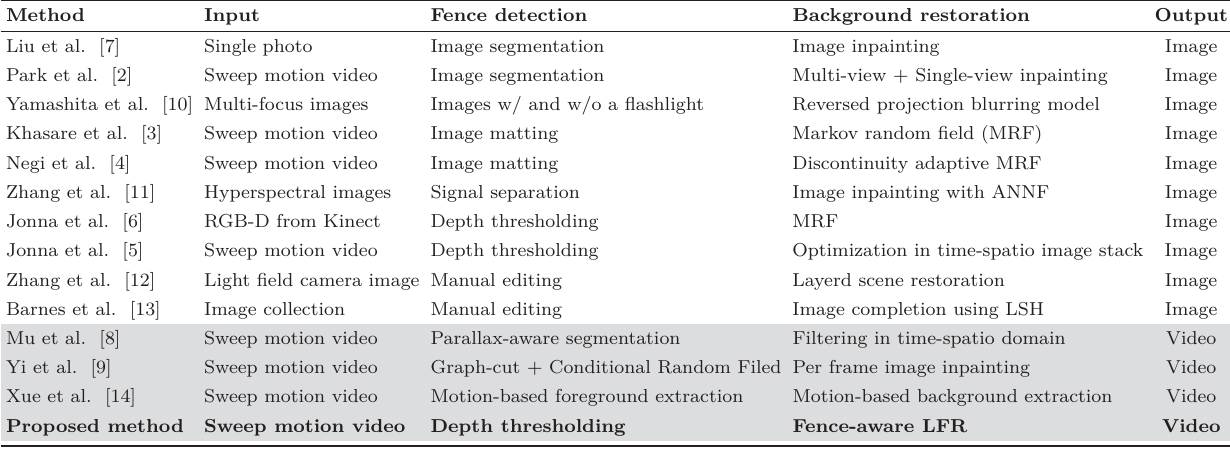
Table 1 Approaches used in various fence removal methods. Plain background: image methods. Grey background: video methods